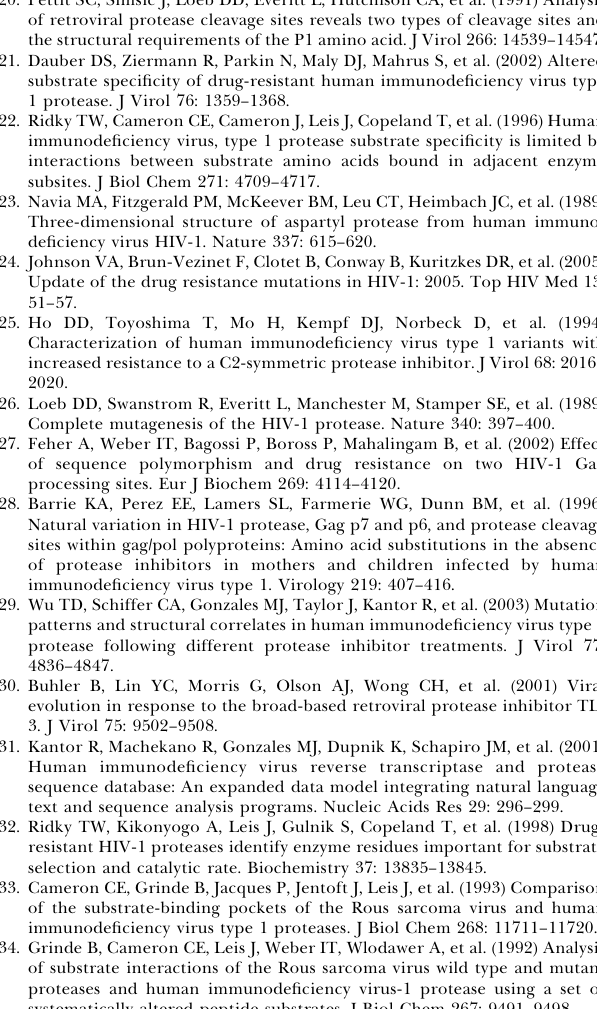
Figure S1. Structural Alignment of Nine Wild-Type Retroviral Proteases Found at doi:10.1371/journal.pcbi.0030048.sg001 (26 KB DOC). Table S1. Summary of the Dataset for Retroviral Proteases Used Herein References to publications, description of the data considered under the study, and the number of entries each article added to the dataset are shown. Table S2. The 61 Retroviral Proteases from Nine Retroviruses Included in the Study Found at doi:10.1371/journal.pcbi.0030048.st002 (21 KB DOC).